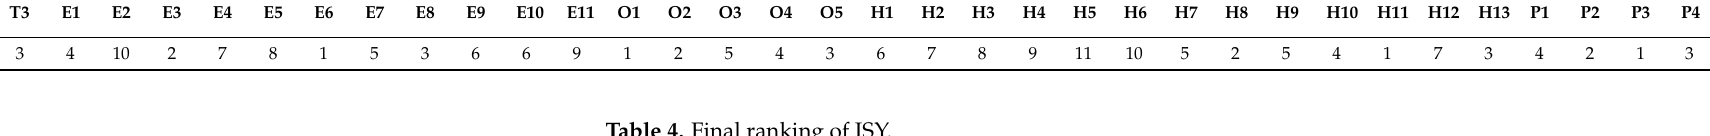
Table 4. Final ranking of